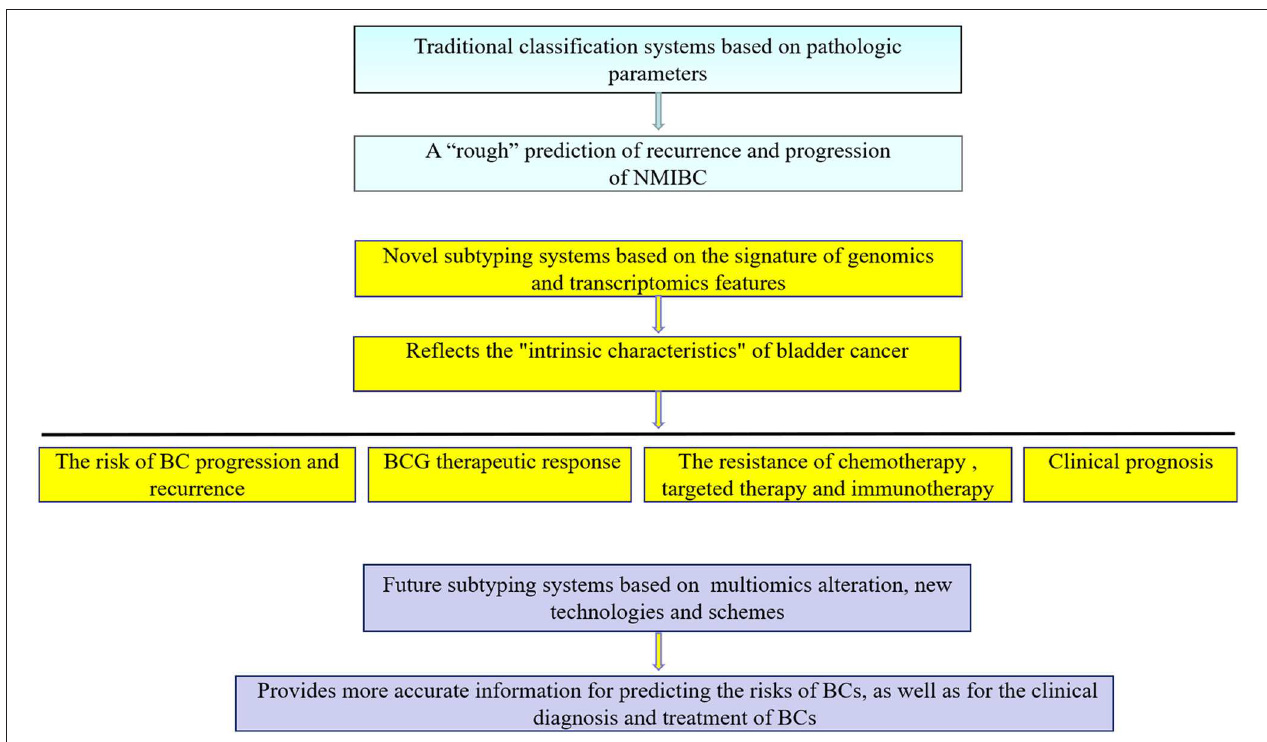
FIGURE 4 | Traditional classification and novel subtyping systems for bladder cancer. NMIBC, Non-muscular invasive bladder cancer; BCG, Bacillus Calmette—Guerin; BCs, bladder cancer